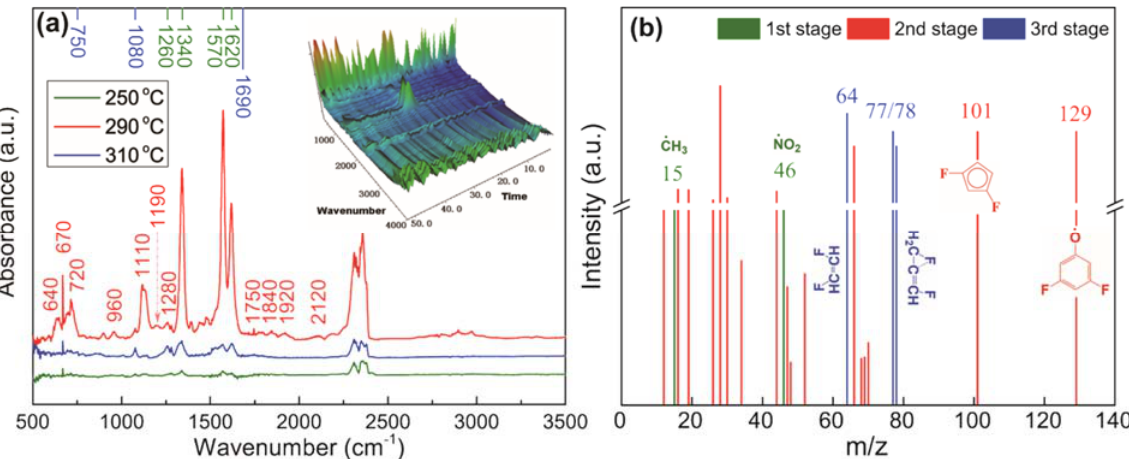
Figure 3. ( a ) FTIR spectra and ( b ) MS patterns of time-resolved decomposition products of DFT-